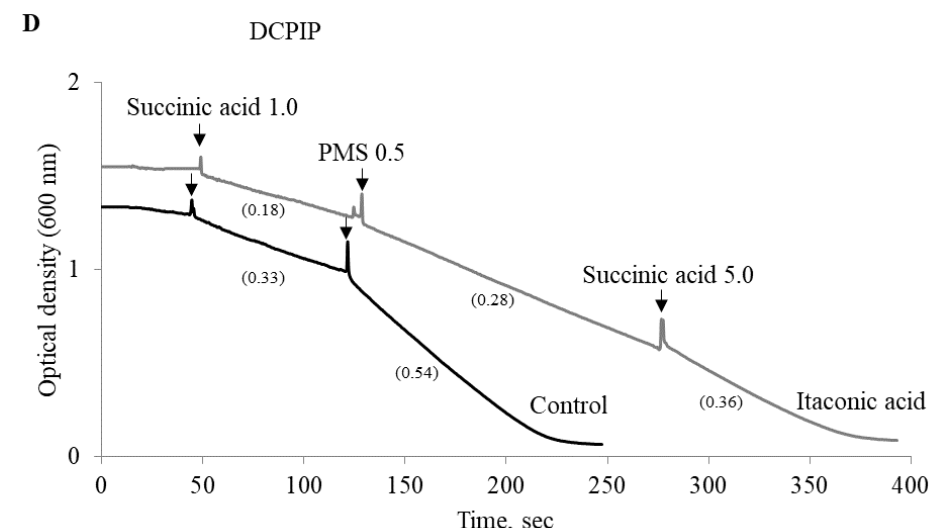
Figure 4. Influence of PhLA, p -HPhLA, p -HPhAA and itaconic acid at a 0.5–5.0 mM concentration range (indicated under the columns) on SDH activity after the 10 min. incubation with rat liver mitochondria measured by MTT reduction ( A ); SDH activation by phenazine methosulfate (0.5 mM PMS) after inhibition by PhLA, p -HPhLA, p -HPhAA and itaconic acid at a concentration for every compound of 5.0 mM ( B ); SDH inhibition by itaconic acid (0.5–5.0 mM) in comparison with malonate (5.0 mM) measured by DCPIP reduction ( C ) and influence of PMS and succinate excess (5.0 mM) on the DCPIP reduction rate during oxidation of succinate (1 mM) in the presence of 5 mM itaconic acid; the rate of DCPIP reduction, ∆ / min, is indicated in parentheses ( D ) ( n = 5, P = 0.95 ).